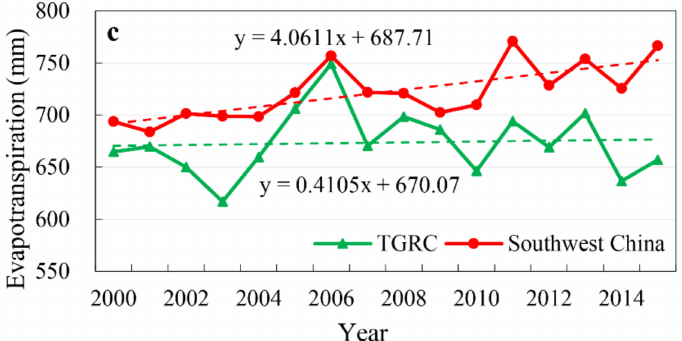
Figure 10. Variation of annual mean ( a ) air temperature, ( b ) precipitation, and ( c ) evapotranspiration in the TGRC and Southwest China from 2000 to 2015. The green line represents the variation in the TGRC, and the red line represents the variation in Southwest China.